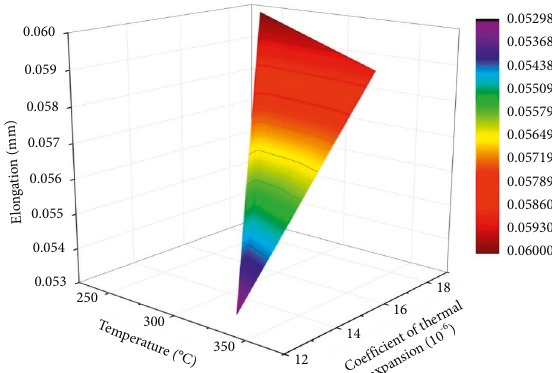
Figure 10: Thermal expansion of the nanocomposites at different